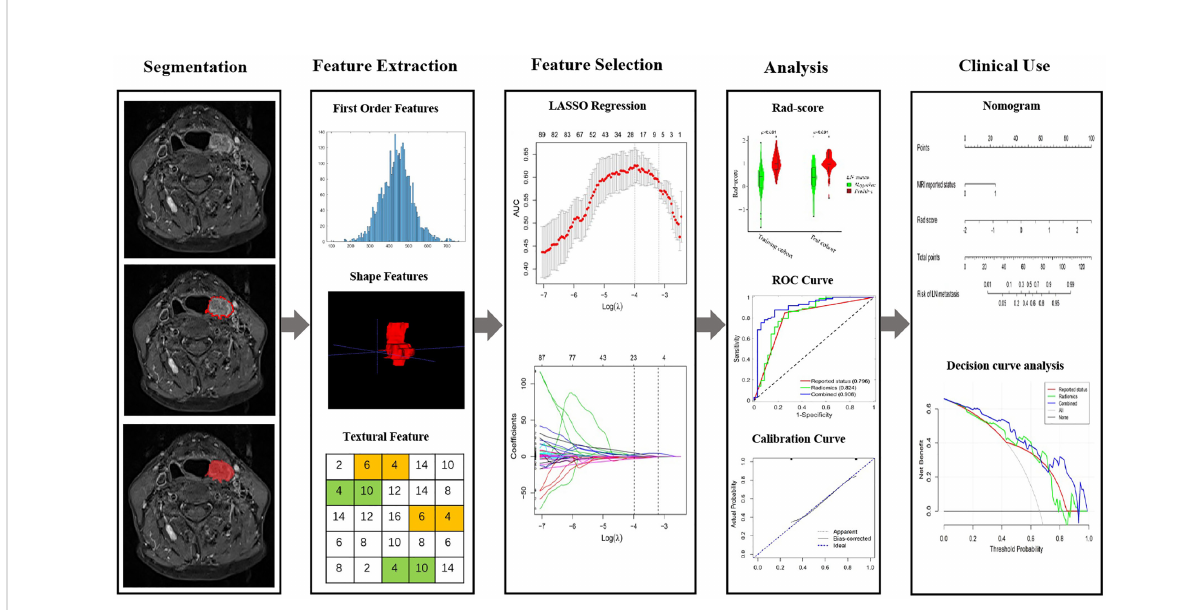
FIGURE 1 The fl owchart of this study. Tumor segmentation was performed on Contrast-enhanced axial T-1 weighted MR images. Experienced otolaryngology head and neck surgeon contoured the tumor areas on MRI slices. Radiomic features to quantify tumor intensity, shape and texture were extracted from original MR data. The LASSO regression was used to select features. The rad-score is constructed by a linear combination of selected features. The performance of the prediction model is assessed by the area under a receiver operating characteristic (ROC) curve and the calibration curve. Radiomics nomogram was established and the calibration curve was used to evaluate the established